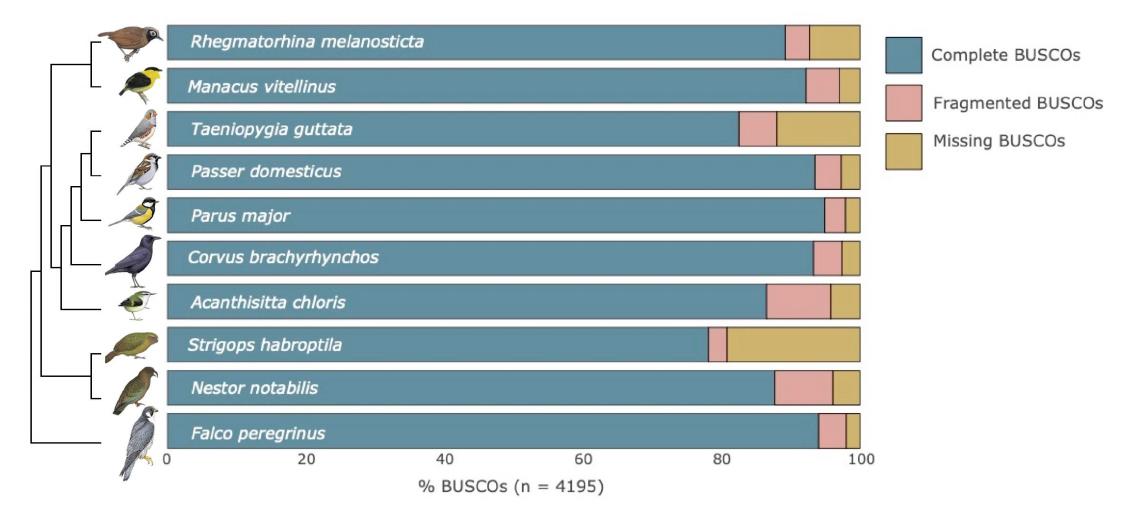
Figure 2. Benchmarking Universal Single-Copy Orthologs version 3 (BUSCO) results for R. melanosticta plus eight related (Eufalconimorphae) non-model genomes. The phylogenetic relationships are based on previous work [8,18]. Bars represent the proportion of complete (blue), fragmented (pink), and missing BUSCOs (gold) for each genome.